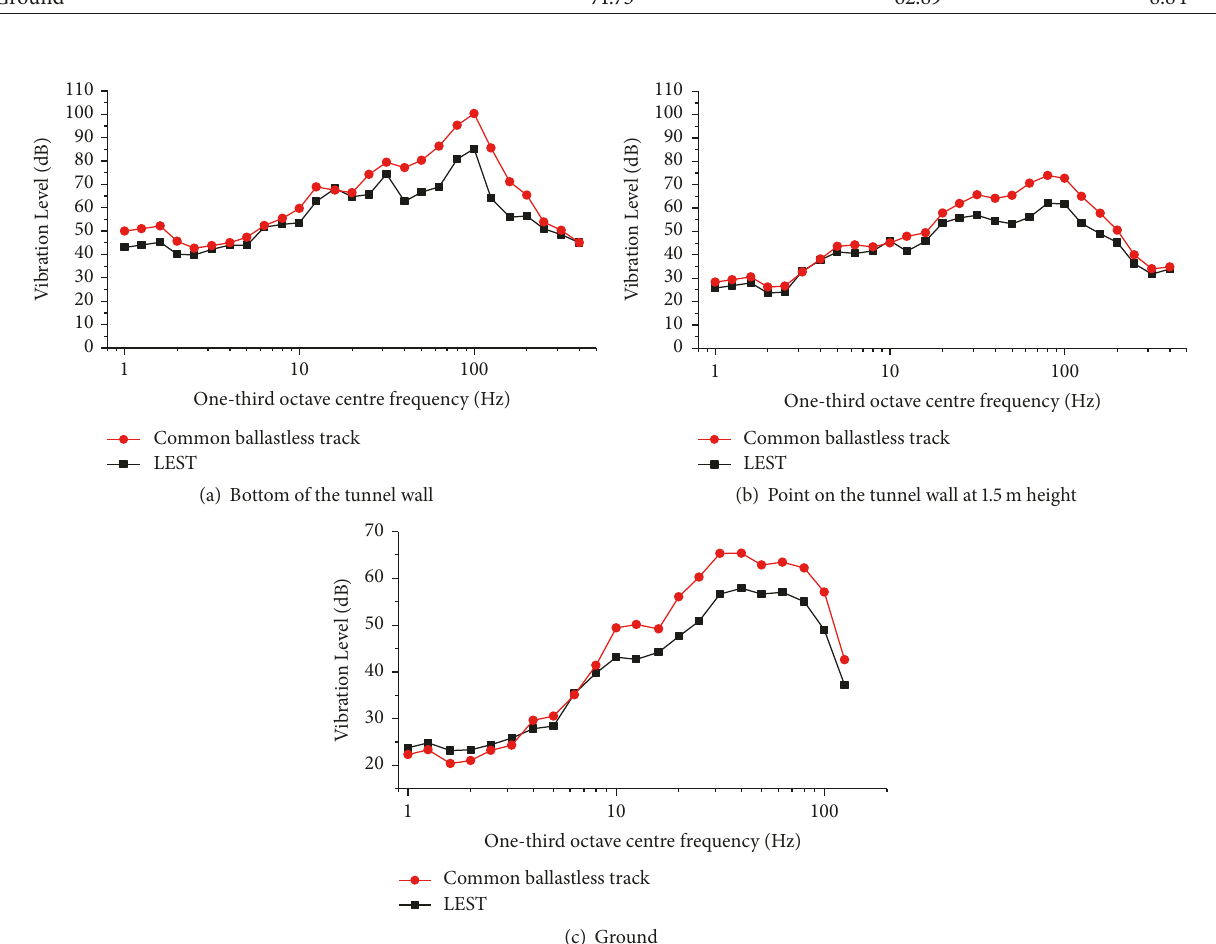
Figure 13: One-third octave curves of the tunnel wall and ground vibration levels in straight